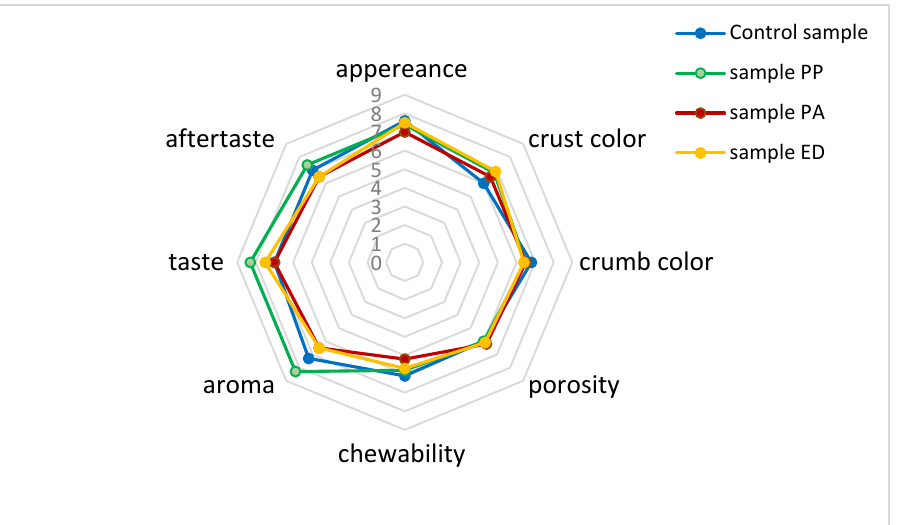
Figure 2. Sensory profile of nongluten pan breads with sourdough. Note: Pediococcus acidilactici 02P108 (PA); Pediococcus pentosaceus 12R2187 (PP); Enteroccocus durans 09B374 (ED).